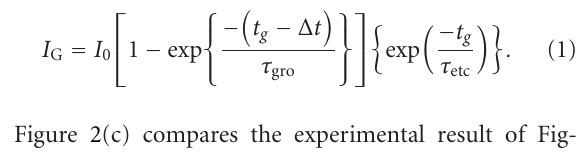
SWNTs during plasma CVD and elucidate the e ff ects of plasma in